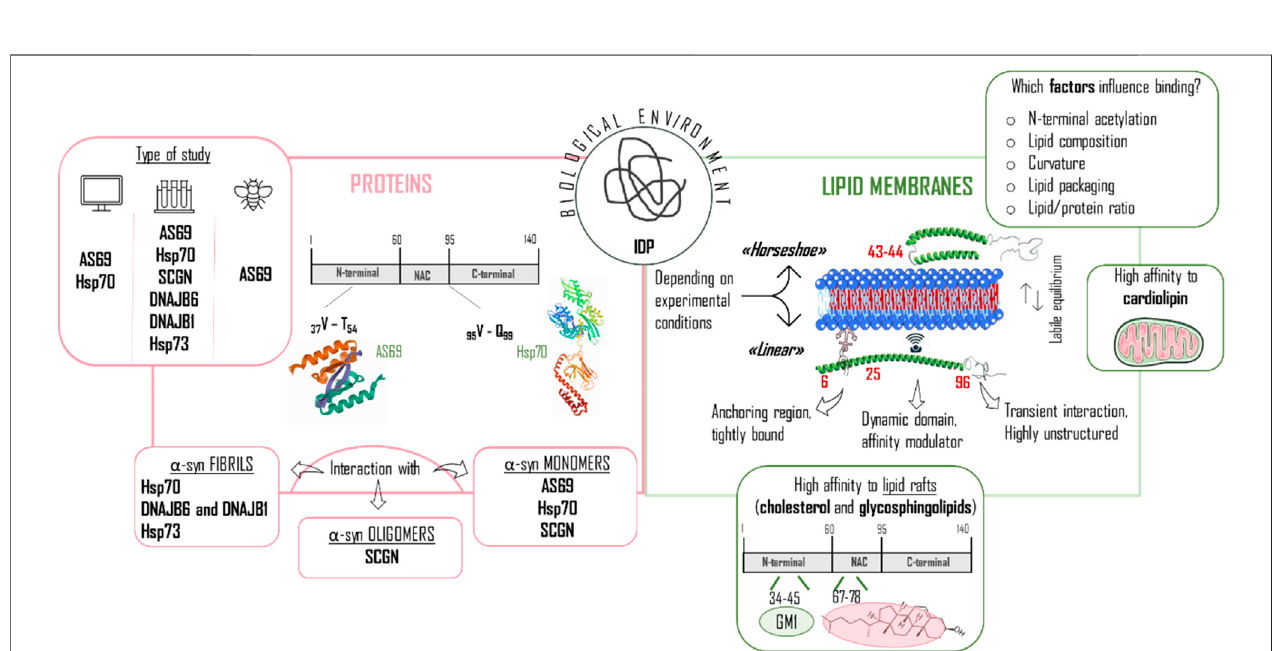
FIGURE 7 | Different biological factors/modulators in fl uencing α Syn structure. The fi gure is composed of two sections referring to proteins (left panel) and lipid membranes (rightpanel) ,whichhaveanimportantroleintheconformationalchangeof α Synfrombeinganintrinsically disorderedprotein(IDP)toinduce amorestable structure. Right panel: special emphasis is placed on the type of study performed, classi fi ed in computational, in vitro and in vivo experiments, and on the particular interaction of the proteins with the distinct α Syn con fi gurations ( fi brils, oligomers, monomers). Hsp70 and Hsp73 heat shock protein 70 and 73; SCGN: secretagogin. Left panel: The equilibrium between horseshoe and linear conformation is highlighted and the partition of α Syn in three regions is depicted to show the different behavior throughout the sequence when in contact with lipid membranes. The important interaction with mitochondrial membranes and lipid rafts is also mentioned here. GM1: